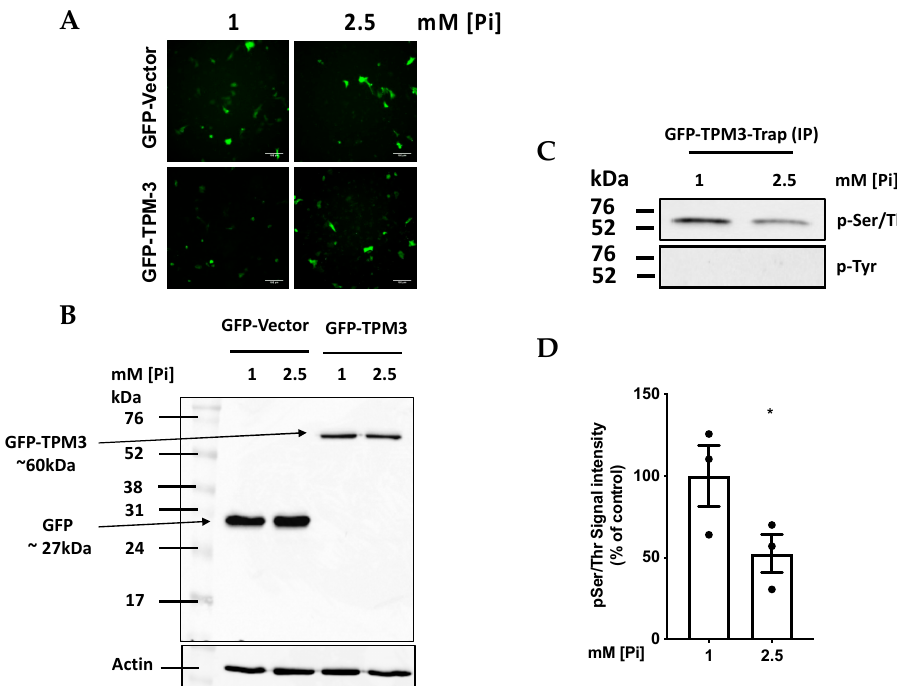
Figure 4. High Pi induces hypophosphorylation of TPM-3 on a Ser / Thre residue. ECs were transfected with empty GFP-vector or GFP-tagged TPM-3. Thereafter cells were treated with 1 vs. 2.5 mM [Pi] for 1.5 h. ( A ) Fluorescence microscopy confirming that the cells were transfected successfully. ( B ) Immuno-blotting using anti-GFP antibody confirming the expression of free GFP (lanes 1 and 2) and TPM-3-GFP (lanes 3 and 4). ( C ) Immuno-blotting using pan-specific antibodies against pSer / Thr (upper panel) and pTyr (lower panel) demonstrating that GFP-trapped TPM-3 from 200 µ g total cellular protein is hypophosphorylated on Ser / Thr but not Tyr in cells treated with 2.5 mM Pi ( D ) densitometry analysis of ( C ), n = 3, * p = 0.033.